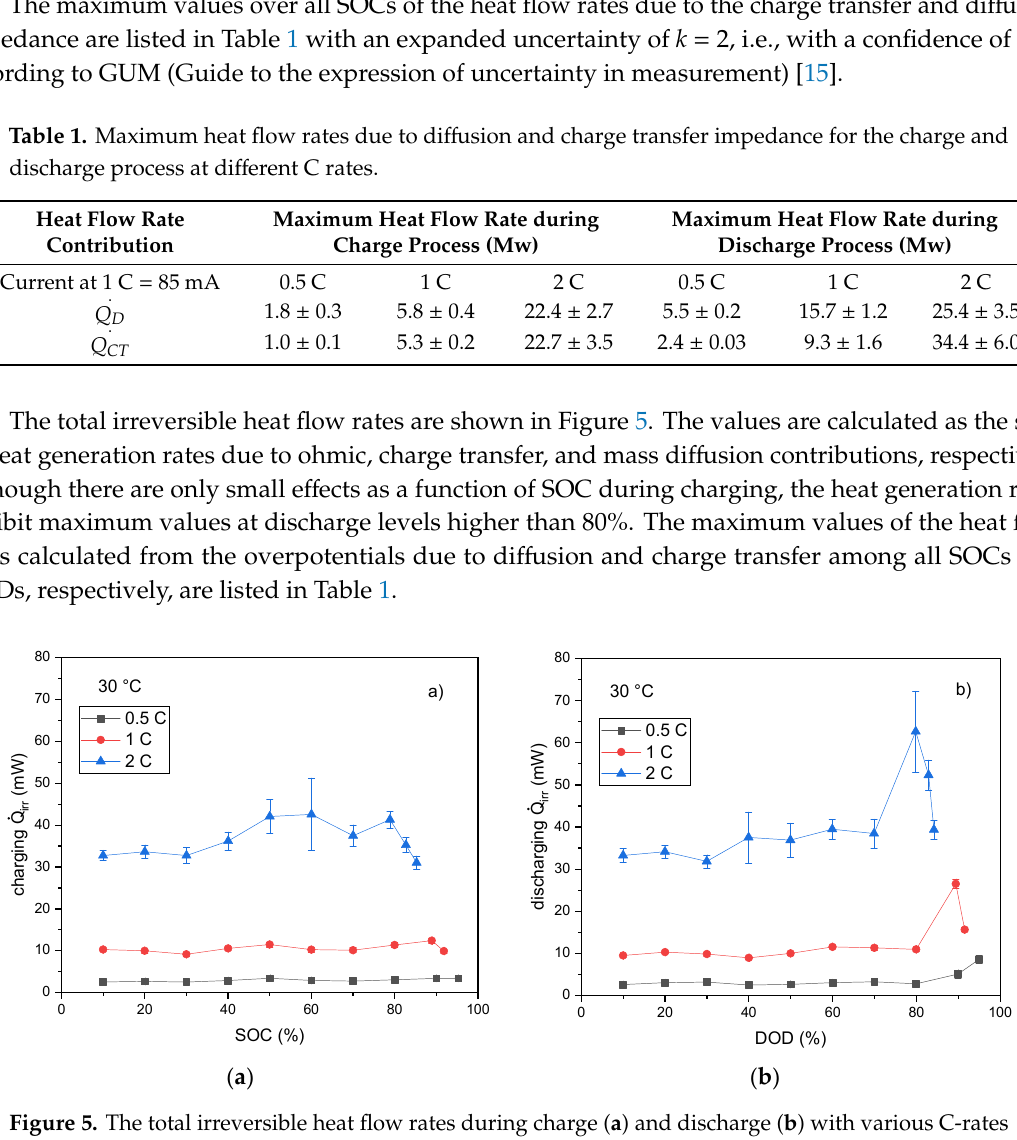
Figure 4. Irreversible heat flow rates due to ohmic, charge transfer, and diffusion impedances during charge and discharge versus SOC ( left ) and depth of discharge (DOD) ( right ).